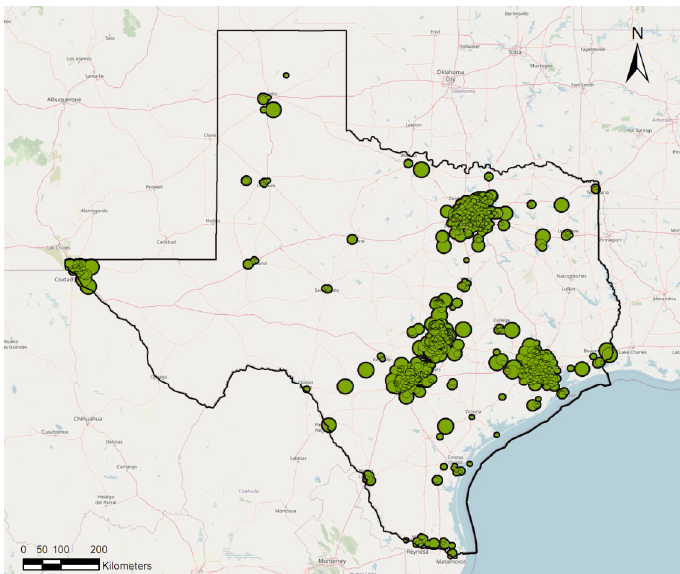
Figure 8. Accessibility of green spaces for green buildings in Texas by visualization.